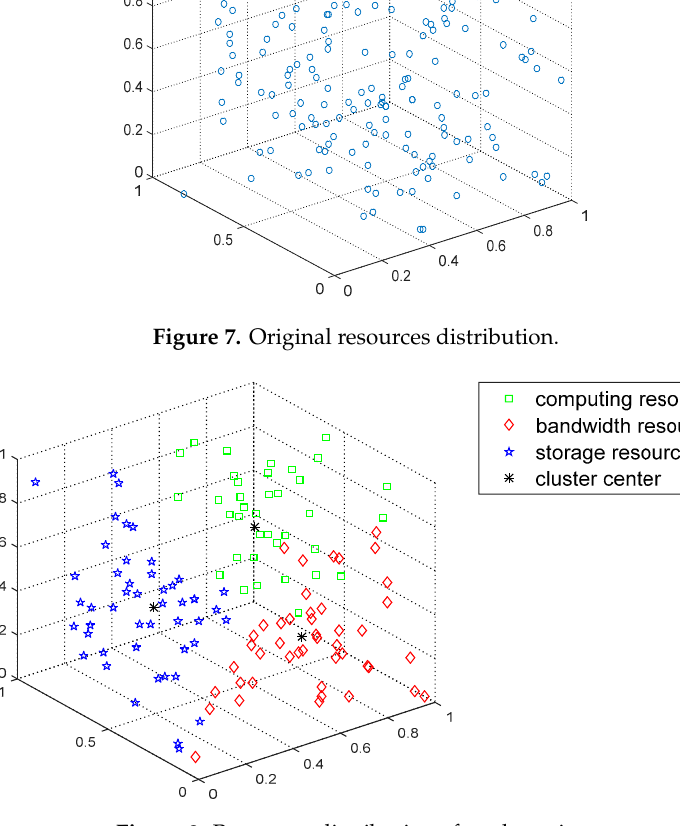
Figure 8. Resources distribution after clustering.